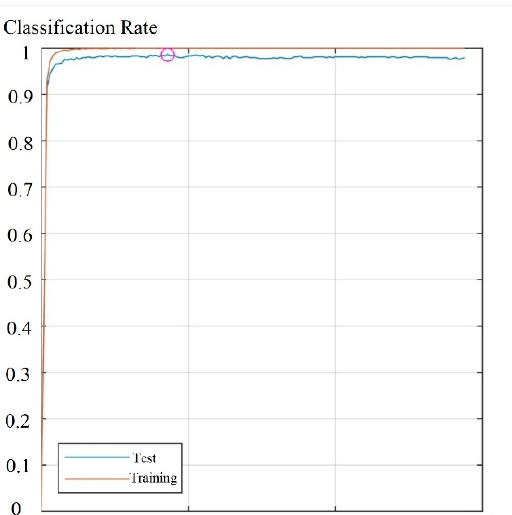
Table 8. Summary of the classification results obtained for four cable sections.